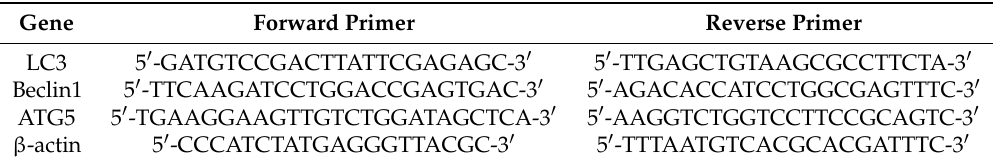
Table 2. Primer sequences for real-time